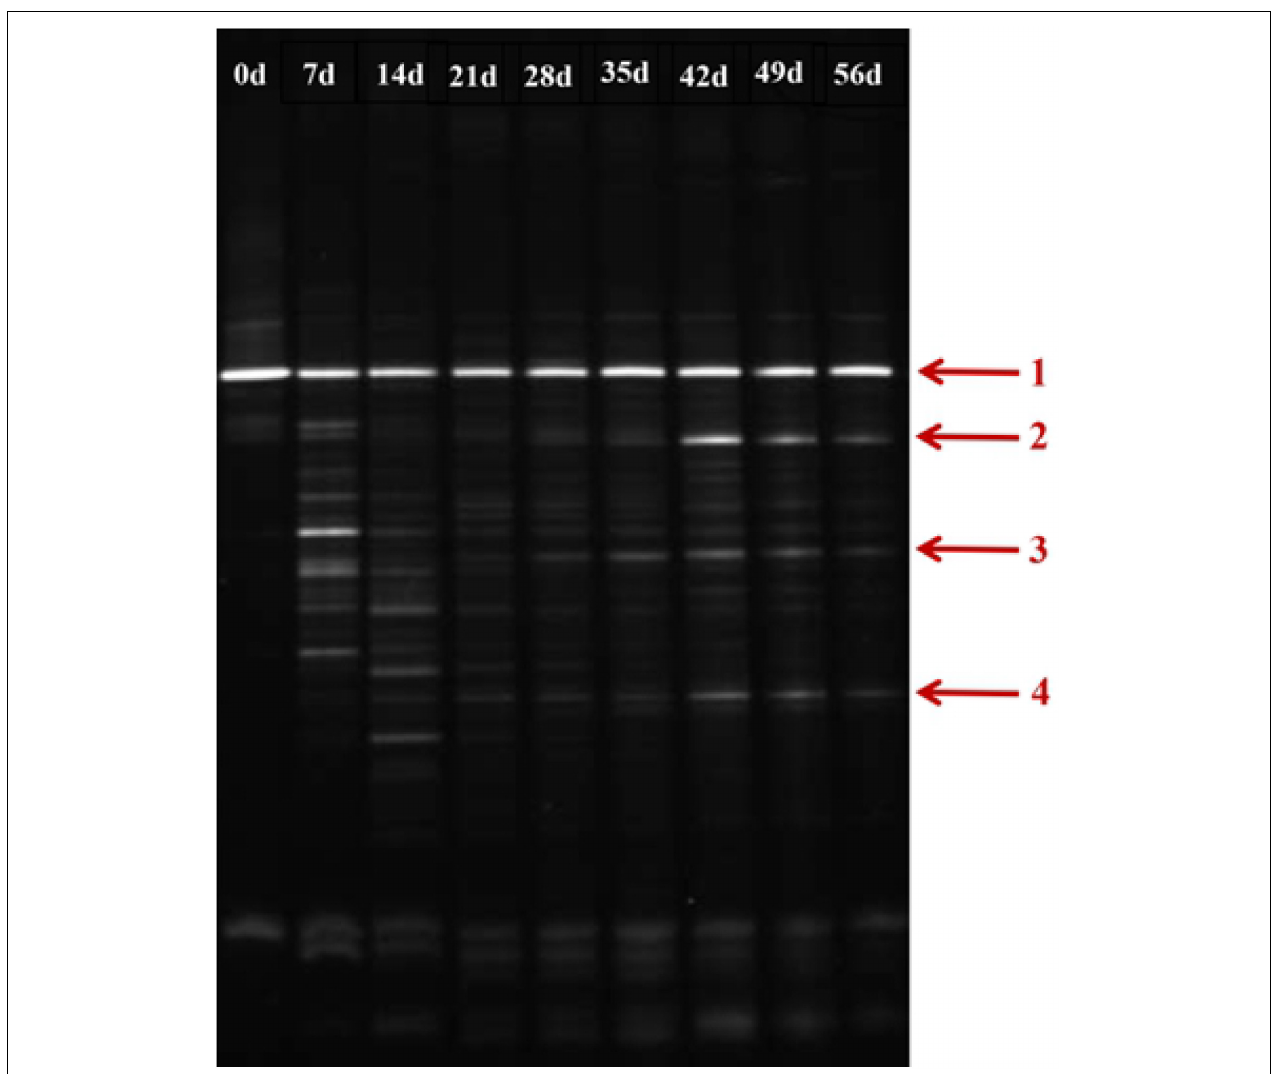
FIGURE 7 | DGGE profile of the biofilm on the PHPS during the 56 days water treatment process (Arrow 1 represents Acinetobacter sp.